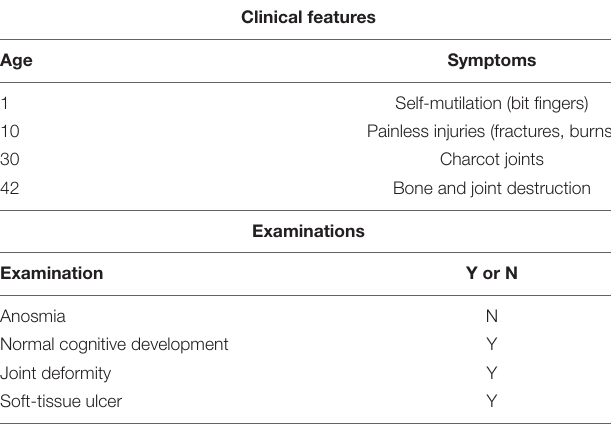
TABLE 1 | Summary of clinical findings in the